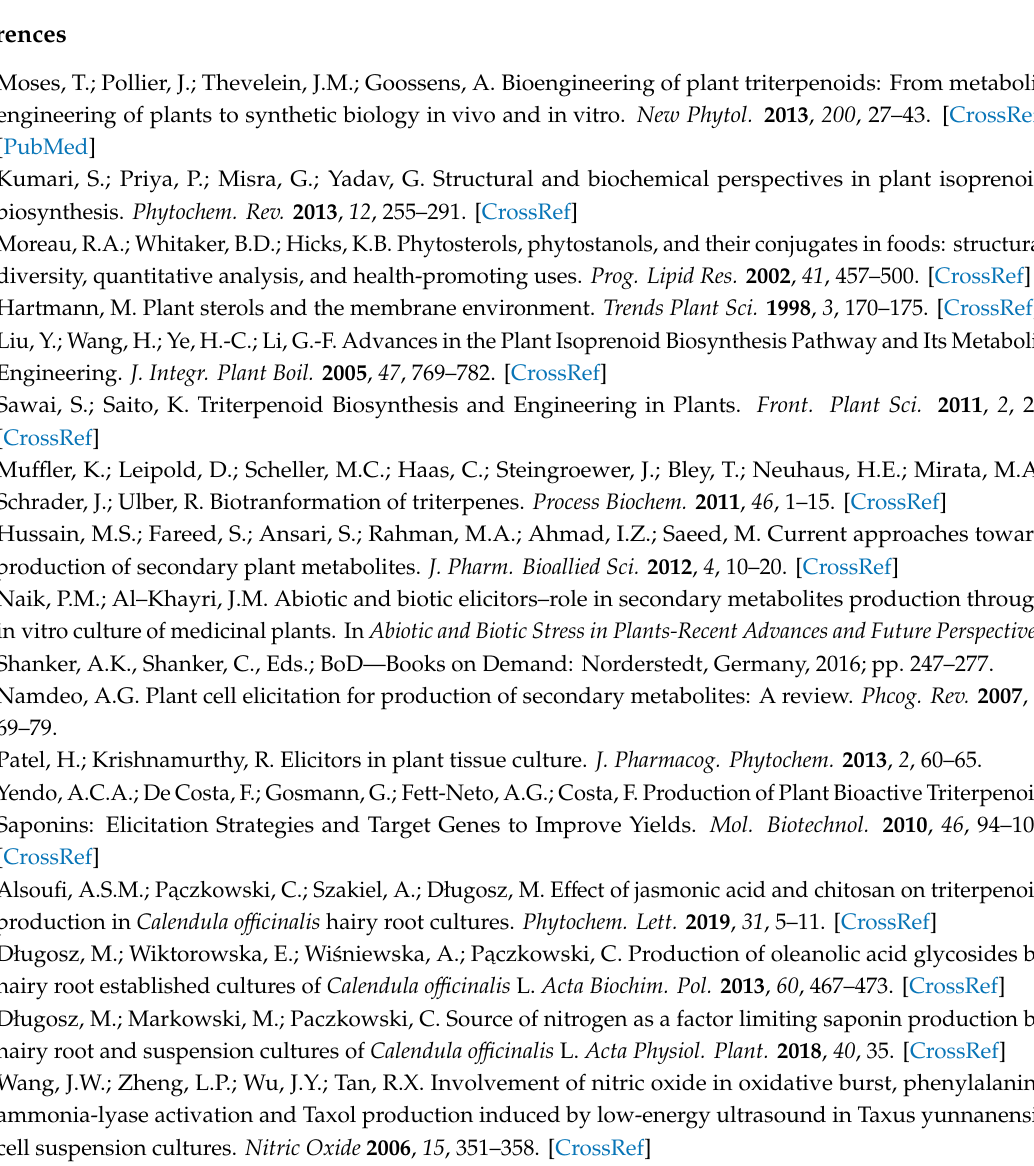
Figure S1: Fresh weight of the line CC16 hairy roots after 7 days of elicitation with silver nitrate or cadmium chloride (25, 50, 100, 150 µ M) compared to the control sample. Figure S2: Dry weight of the line CC16 hairy roots after 7 days of elicitation with silver nitrate or cadmium chloride (25, 50, 100, 150 µ M) compared to the control sample. Figure S3: Hairy root morphology (line CH2) after 7 days of treatment with 100 µ M Ag + and the control culture. Figure S4: Fresh weight of the CC16 and CH2 hairy root lines after elicitation with ultrasound. Figure S5: Dry weight of the CC16 and CH2 hairy root lines after elicitation with ultrasound. Figure S6: Hairy root morphology (line CH2) after 10 min and 20 min of exposure to ultrasound and 7 days of subsequent culture, compared to the control. Figure S7: Fresh weight of the CC16 and CH2 hairy root lines after elicitation with UV-C radiation. Figure S8: Dry weight of the CC16 and CH2 hairy root lines after elicitation with UV-C